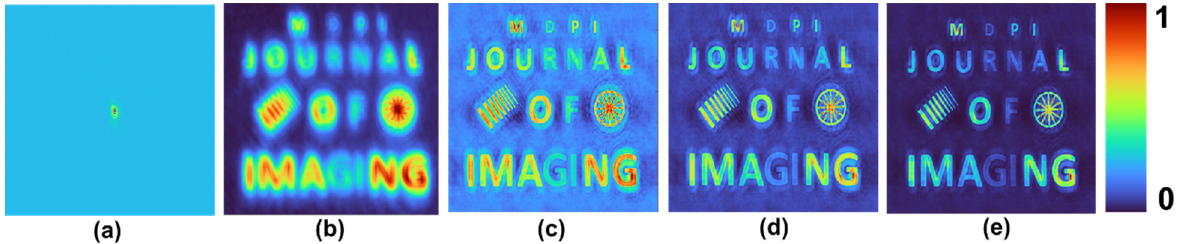
Figure 10. ( a ) Recorded PSF, and ( b ) object’s response pattern. Reconstruction results using ( c ) NLR ( p = 1), ( d ) NLR ( p = 2) and ( e ) NLR ( p = 3) for a diffractive lens. ( p = 1), ( d ) NLR ( p = 2) and ( e ) NLR ( p = 3) for a diffractive